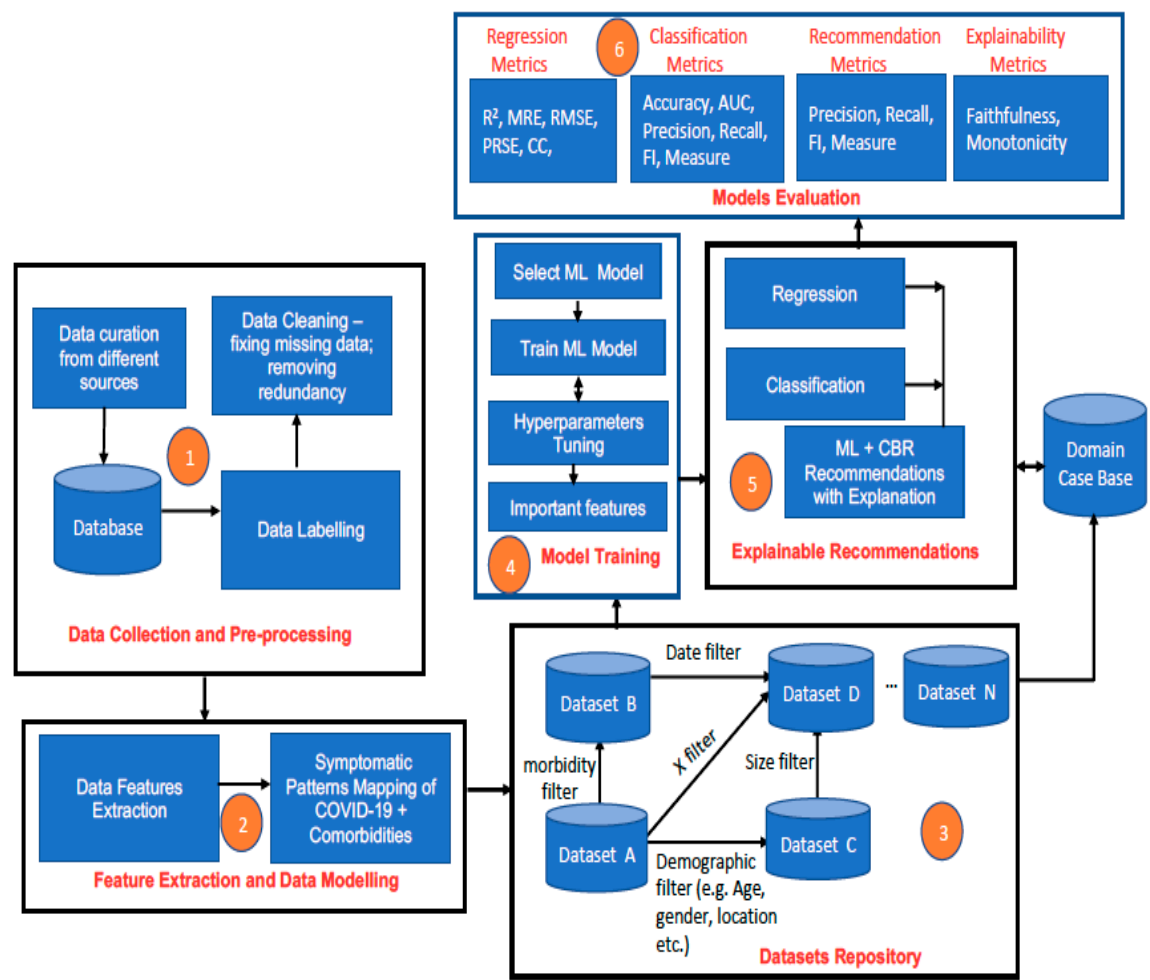
Figure 2. The architecture of the AI engine of the proposed framework for multimodal diagnostics and management of COVID-19 and comorbidities.